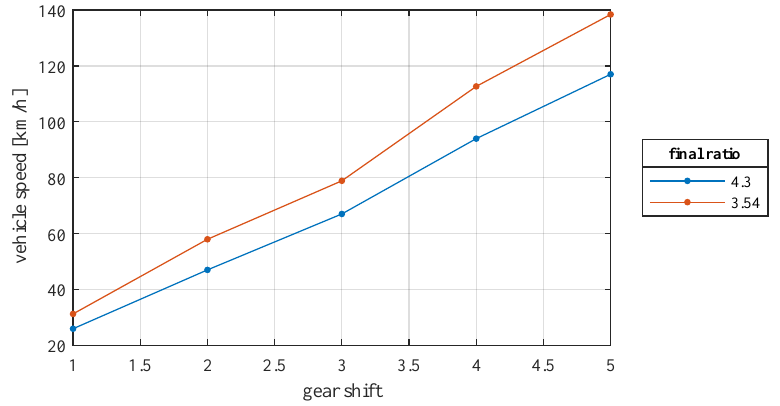
Figure 8. Vehicle speed with final ratios of 4.3 and 3.54 for all the gear